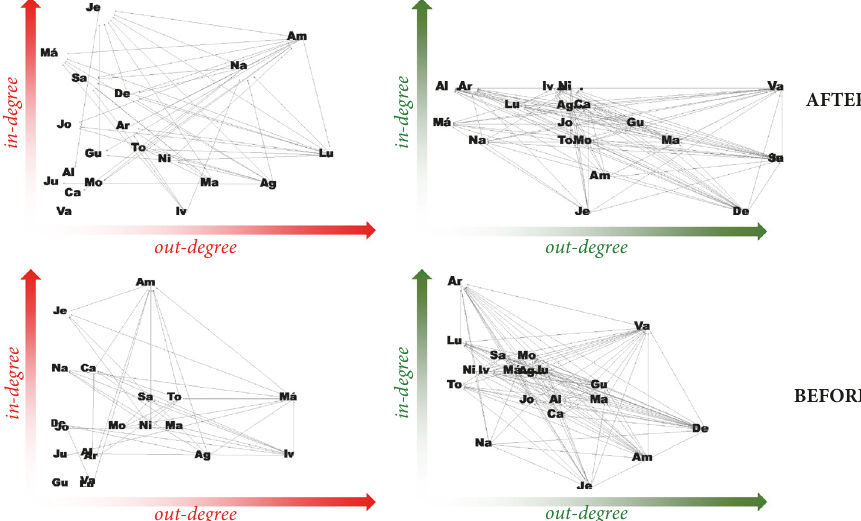
Figure 5: Control group networks. NNs (left) and PNs (right), in the first (bottom) and second evaluations (above). Network layouts show nodes which have a high number of in-degree connections located upper across the vertical axe and those with high number of out-degree connections located at the right of the horizontal